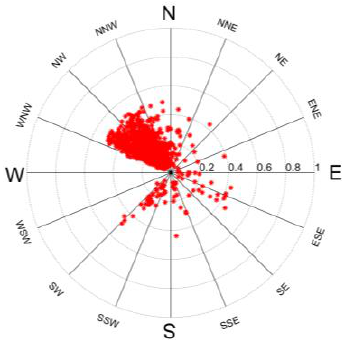
Figure 9. Polar coordinate scatter plot of the α index.